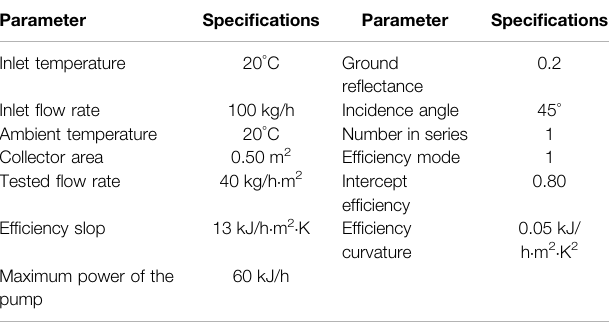
TABLE 1 | Speci fi cations of TRNSYS model.